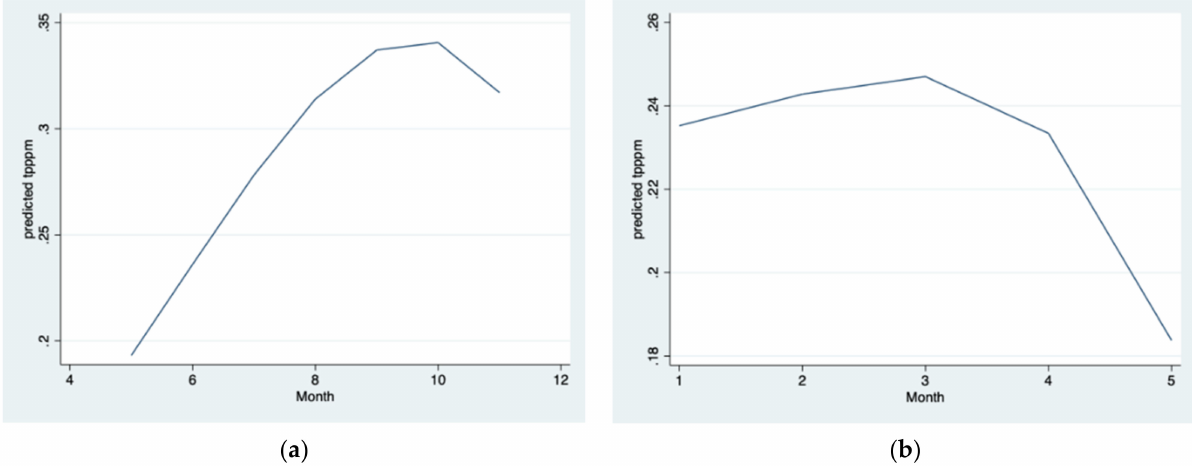
Figure 15. Fractional polynomial regression between monthly means (1994–2018) of TPout concentration (ppm) and no-crane months (5–11) ( a ) and crane months (12, 1, 2, 3, 4) ( b